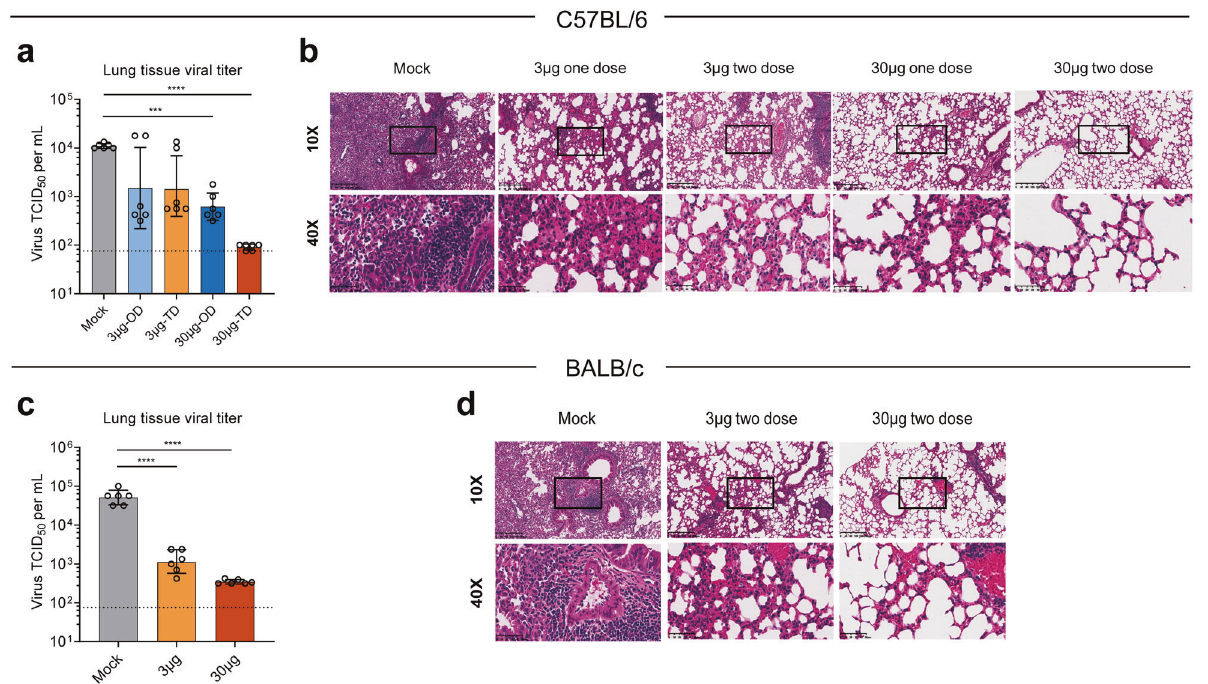
Fig. 5 Induction of ef fi cient protection against SARS-CoV-2 in mice by SW0123. C57BL/6 mice received either an one-dose (OD) vaccination with 3 or 30 μ g SW0123 in week 0, or two-dose (TD) vaccinations with the same dosage in weeks 0 and 3. BALB/c mice were immunized twice with 3 or 30 μ g SW0123 in weeks 0 and 3. Mice in the mock group were administrated with empty vector as control. Mice ( n = 6 each group) were transduced with rAdV5-expressing hACE2 13 weeks after fi rst dosing, and were challenged intranasally with 5 × 10 5 TCID50 of